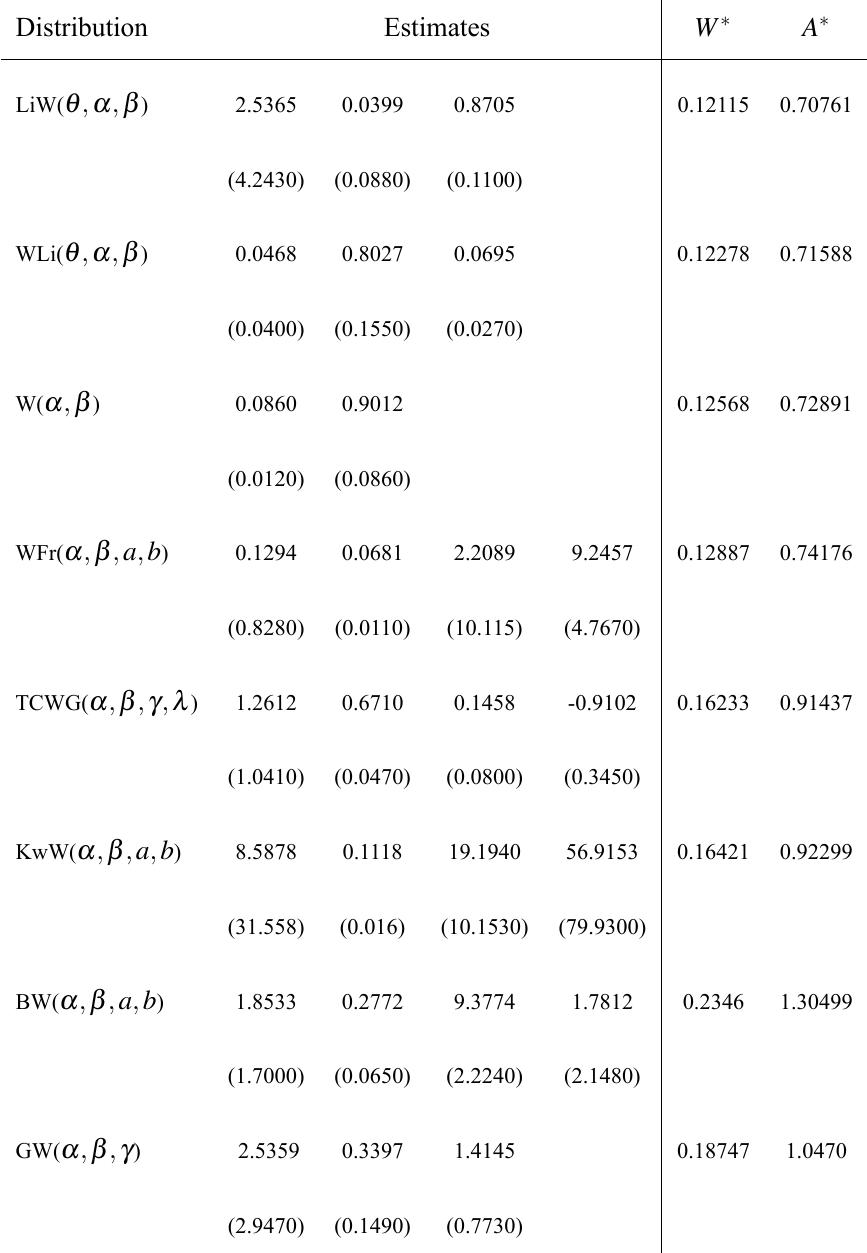
MLEs (standard errors in parentheses) and the statistics W ∗ and A ∗ for data set